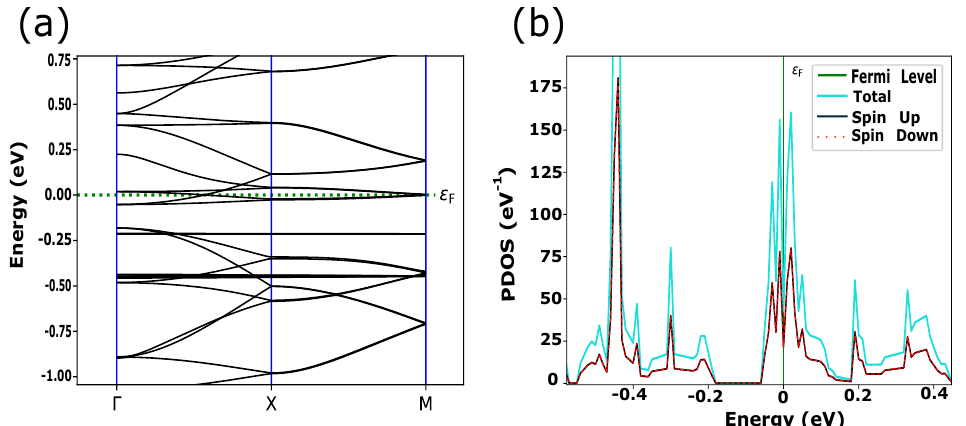
Figure 5. ( a ) Band structure in CuPPC ( b ) PDOS for